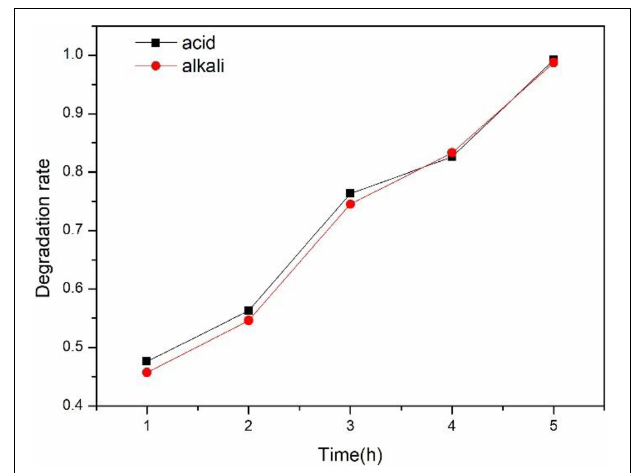
FIGURE 6 | Effect of temperature on degradation rate.